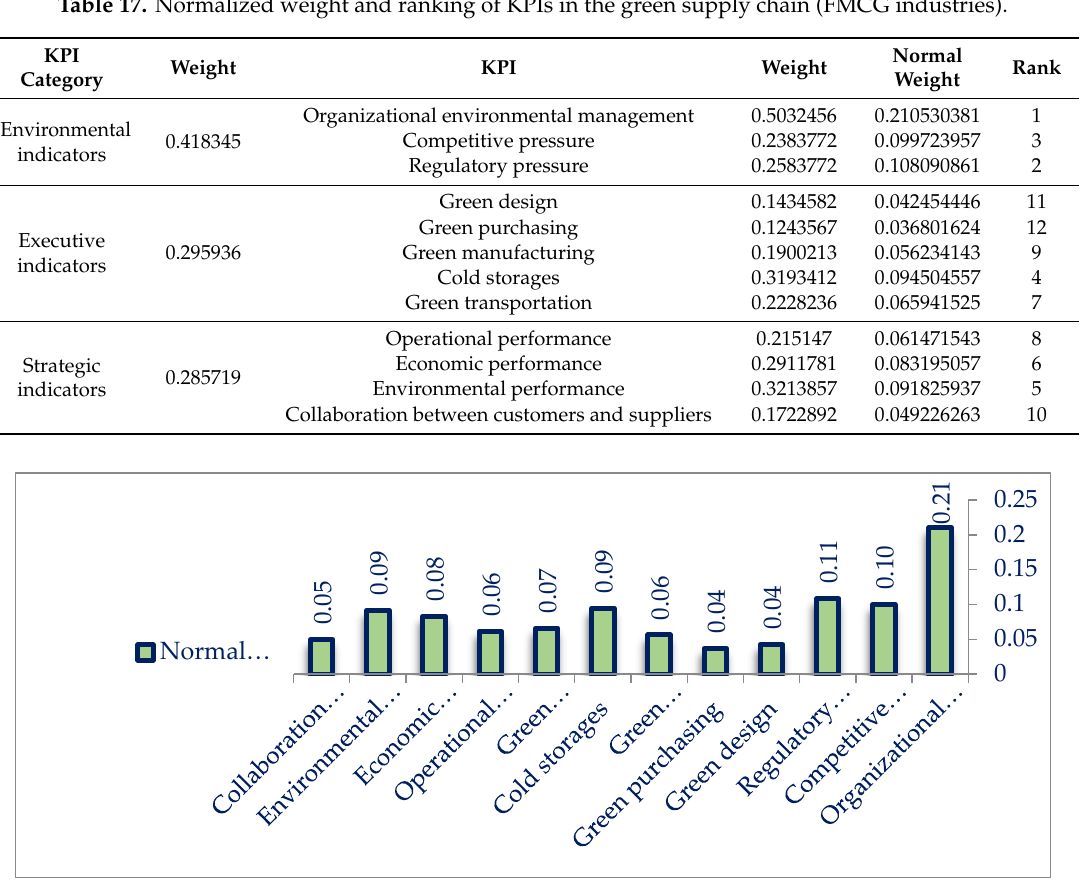
Figure 3. Importance of KPIs of the green supply chain in the FMCG industry.